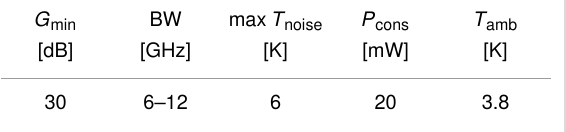
Table 1: The main parameters of the cryogenic LNA. G min BW max T noise P cons